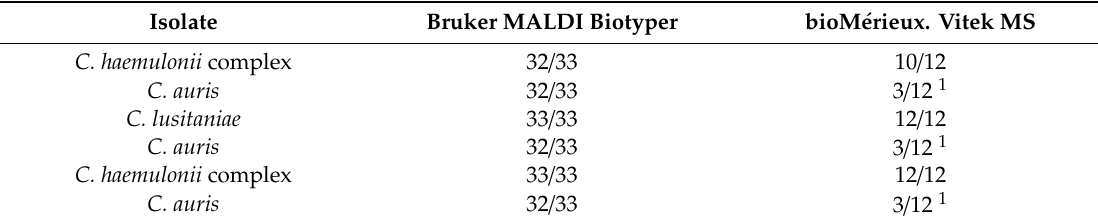
Table 1. Identification of C. auris , C. haemulonii complex, and C. lusitatiae by two